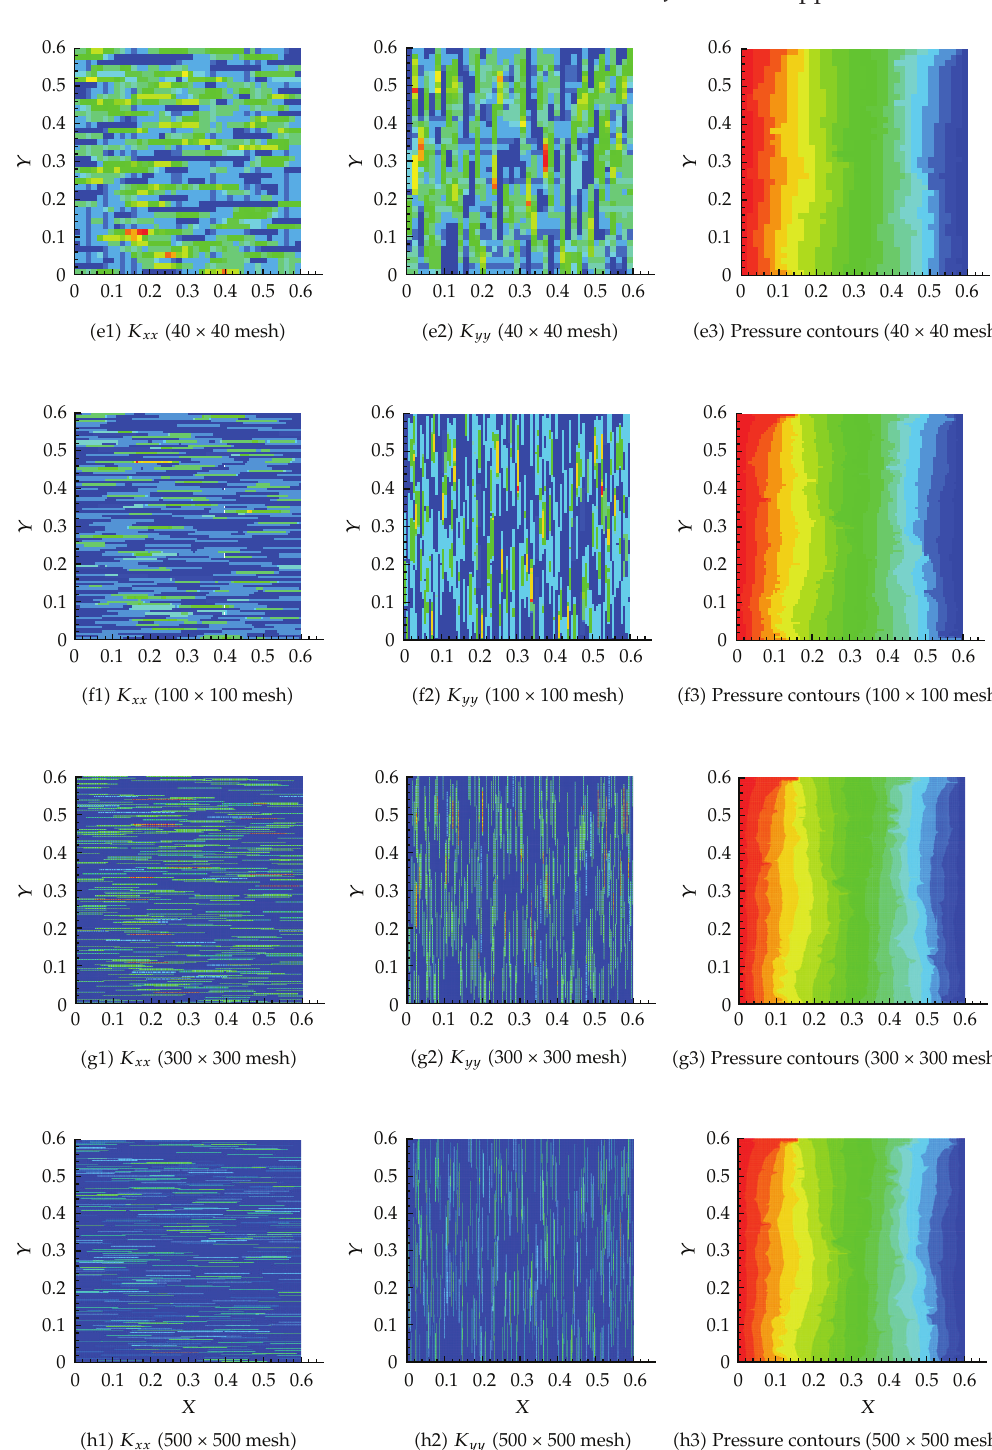
Figure 12: E ff ective permeability and pressure contours for the 800 fractures scenarios for di ff erent degrees of